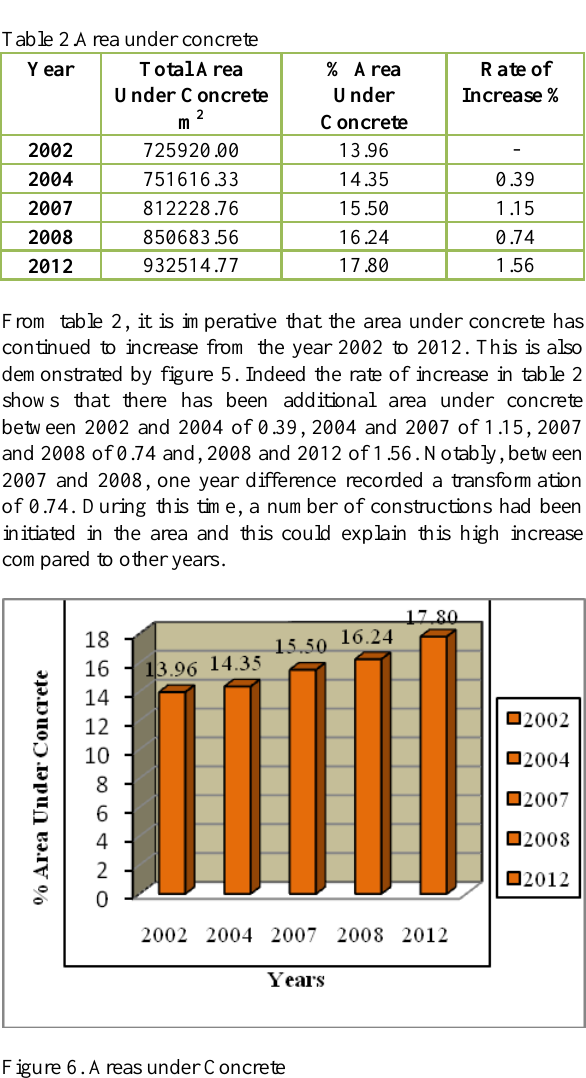
Table 1. Comparison of Green and Concrete Areas